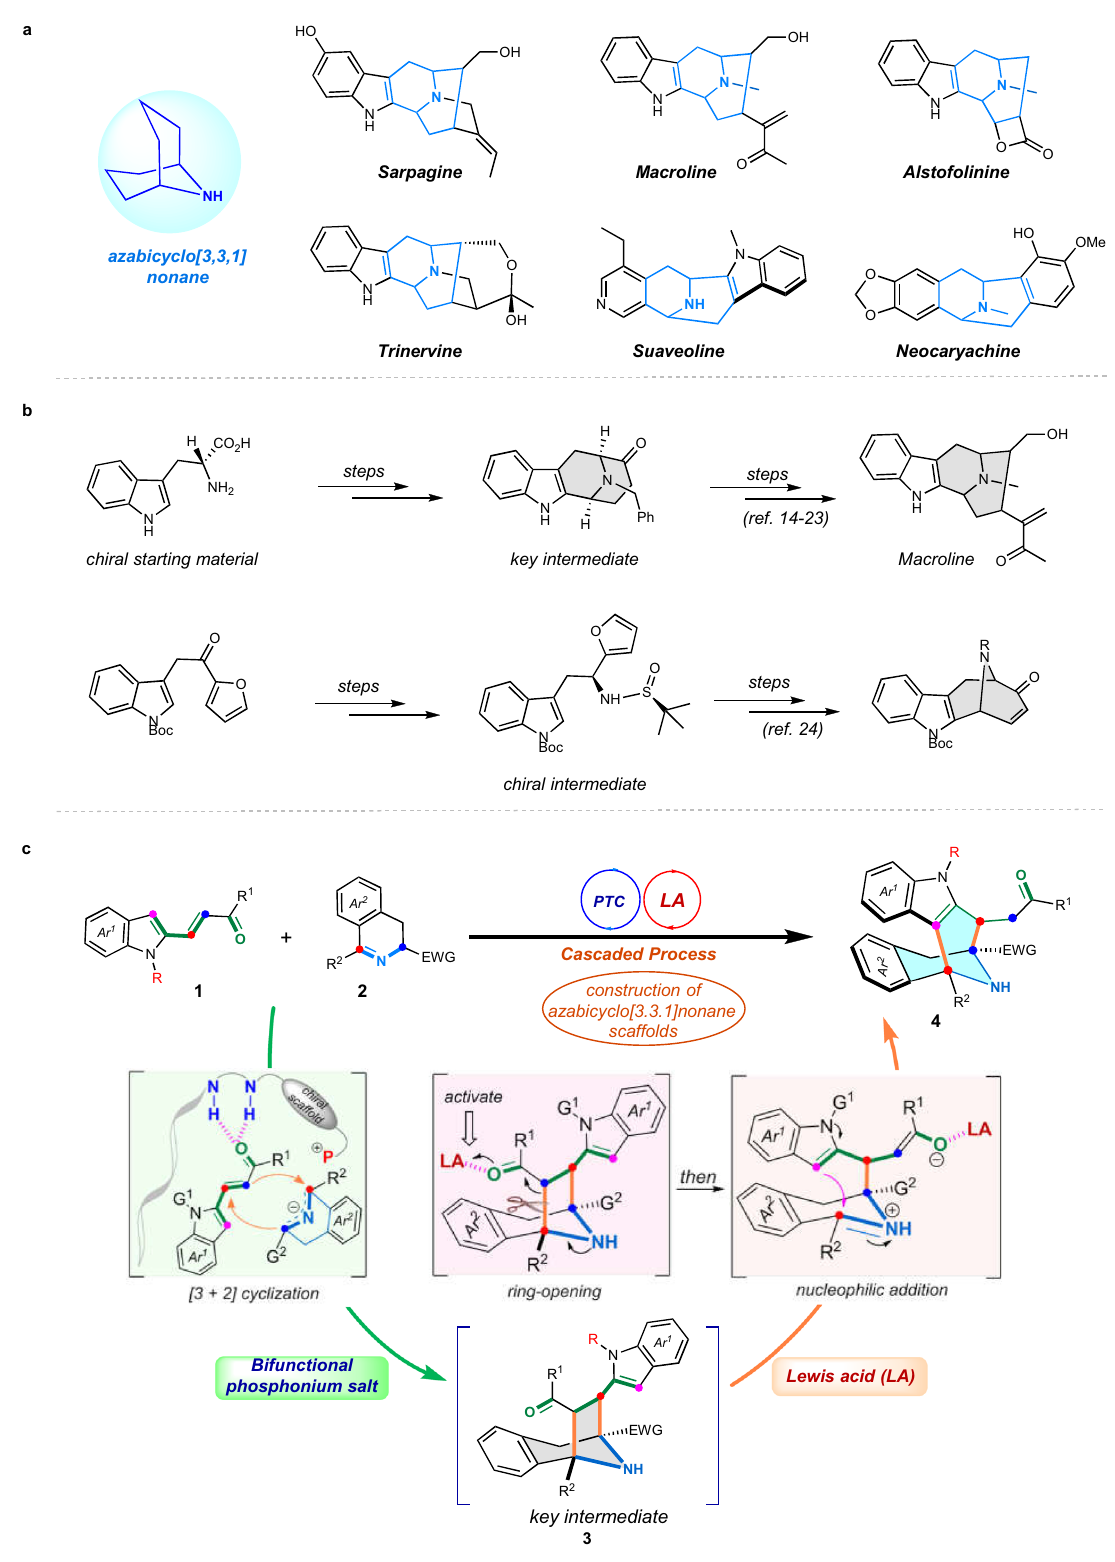
Fig. 1 Chiral aryl-fused azabicyclo[3.3.1]nonane compounds and their synthesis. a Representative bioactive molecules containing aryl-fused azabicyclo[3.3.1]nonane framework. b Reported total synthesis strategies for preparing chiral azabicyclo[3.3.1]nonane scaffolds. c The fi rst catalytic asymmetric approach to construct azabicyclo[3.3.1]nonane molecules by metal-free relay catalysis (this